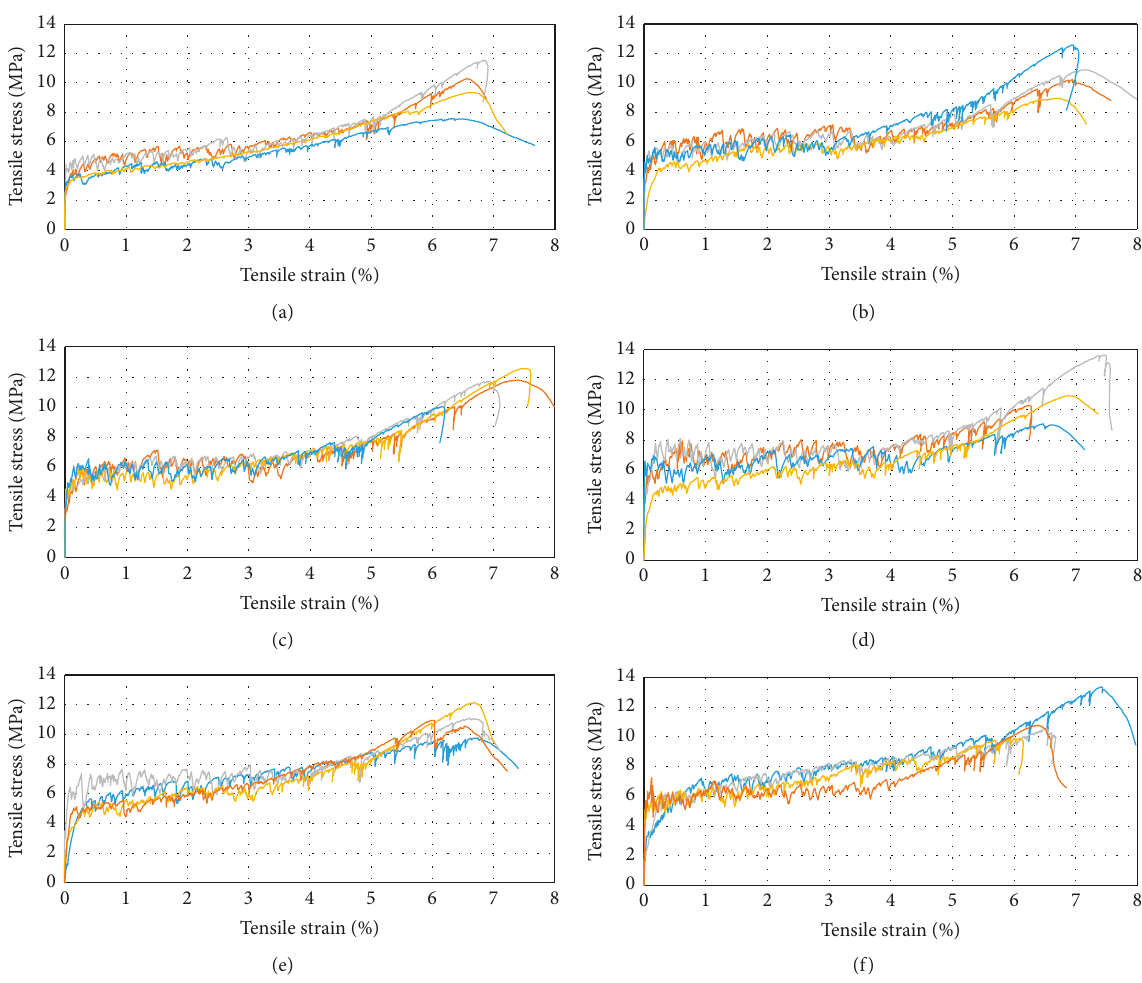
Figure 3: Tensile stress and strain curves: (a) 3days; (b) 5 days; (c) 7days; (d) 14days; (e) 28days; (f) 90days. Table 5: Uniaxial tensile